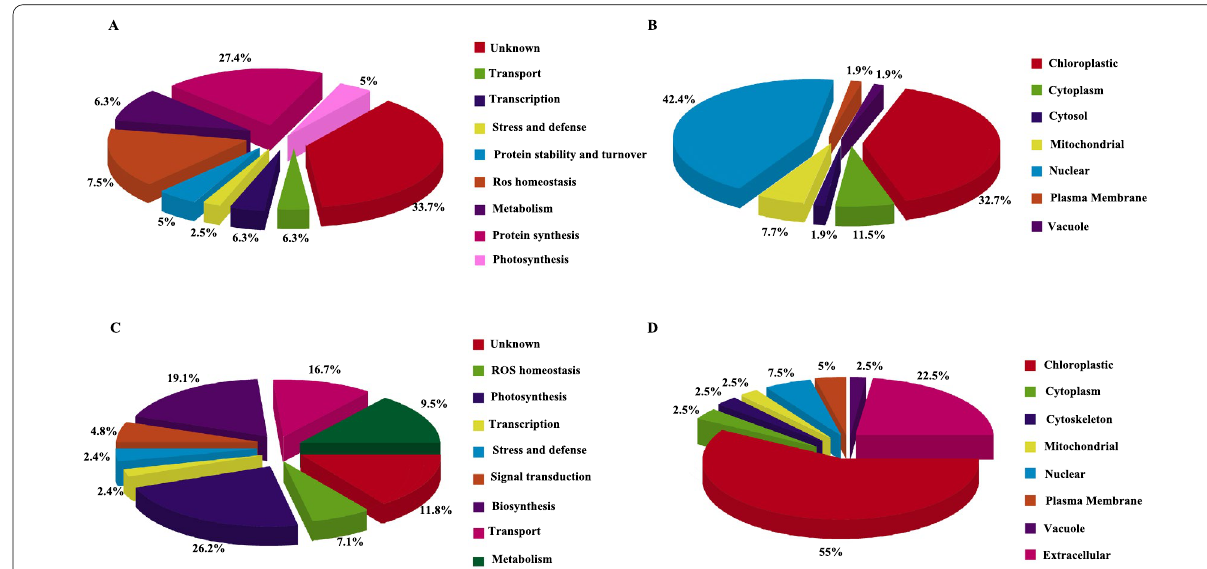
Fig.2 Functional classification and subcellular location of the differential redox proteins and differential proteins. A Functional classification of 80 differential proteins; B Subcellular location of 80 differential proteins; C Functional classification of 42 differential redox proteins; D Subcellular location of 42 differential redox